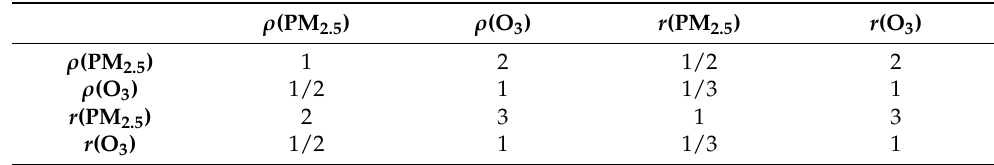
Table A1. Subjective evaluation matrix of four indicators.